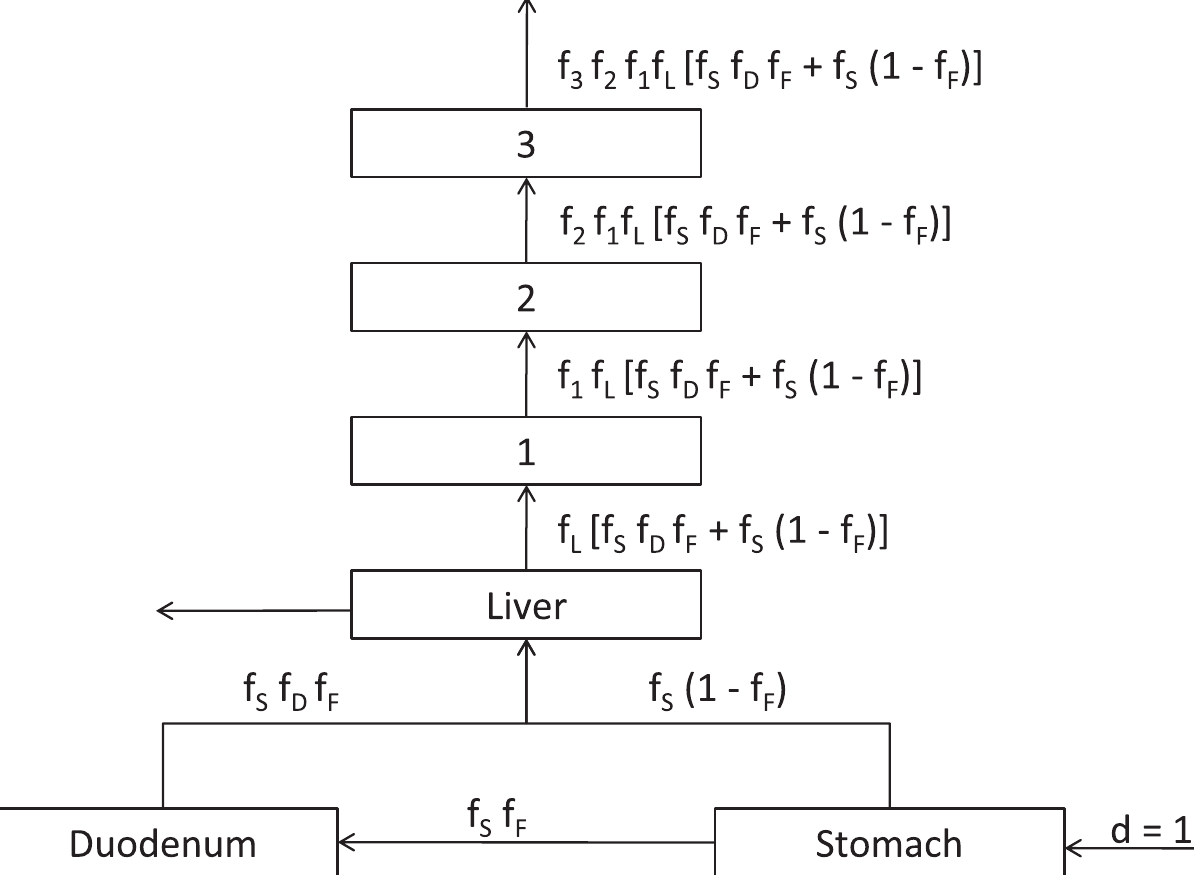
Fig 3. Definition diagram for a generalized, physiologically-based, first-order model of a liver-mediated toxicological pathway, including a terminal series of three generalized pharmacodynamic steps.